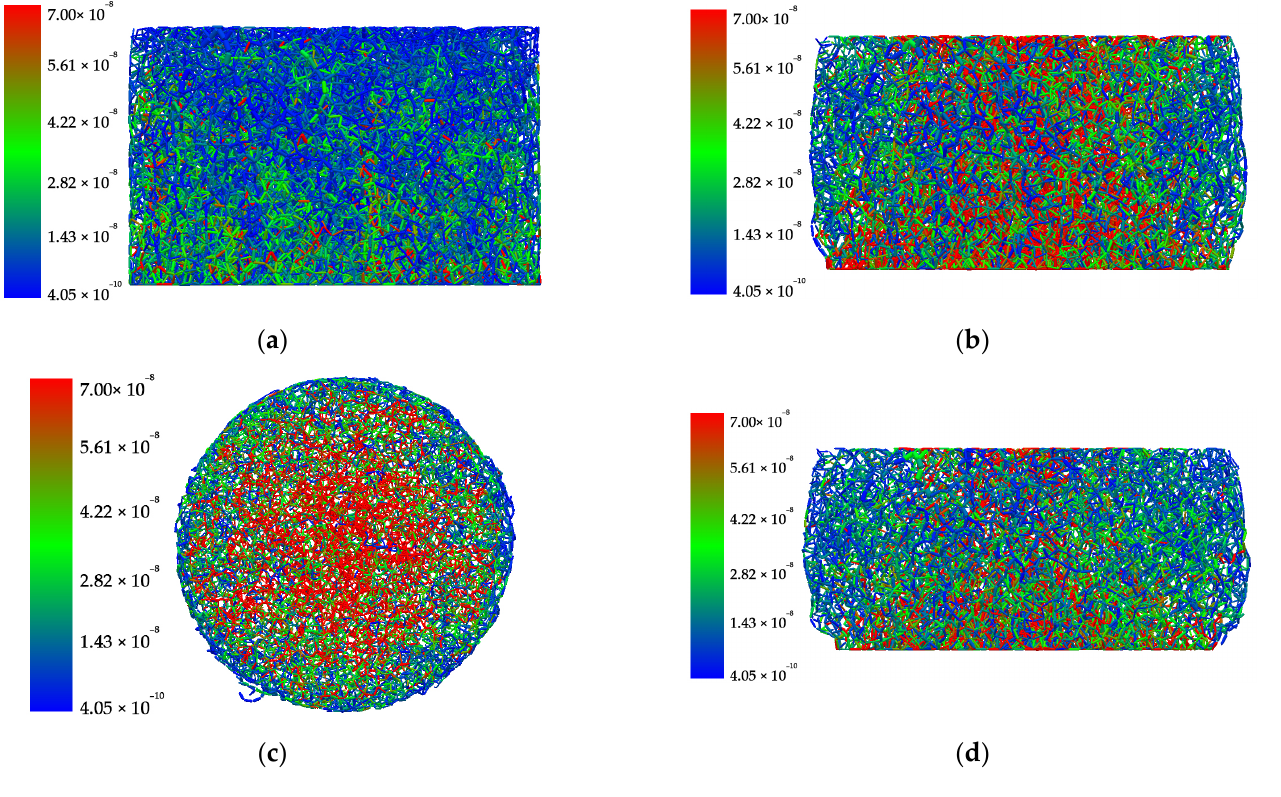
Figure 11. Bonding force distribution during the simulation test of unconfined compression: ( a ) start of compression; ( b ) front view of maximum stress; ( c ) top view of maximum stress; ( d ) end of com-